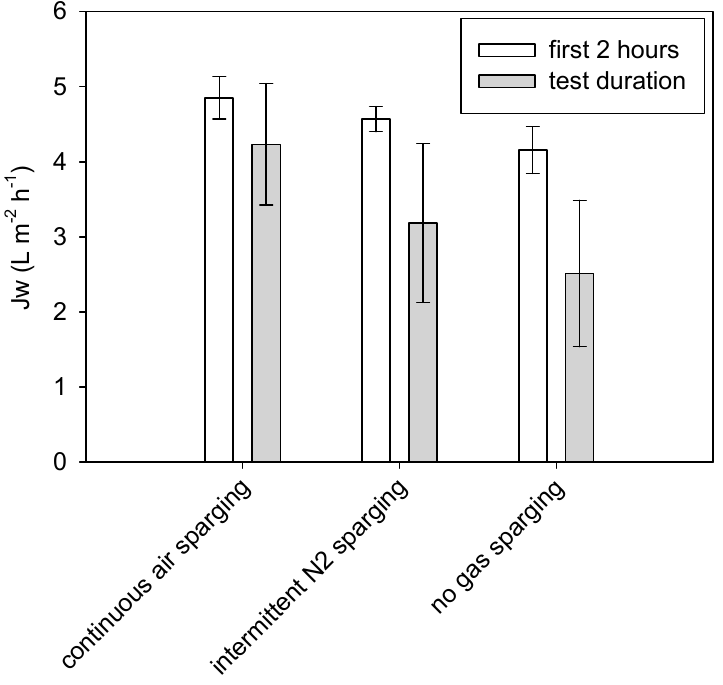
Figure 5. Average water flux with standard deviation during the first 2 h of each test and during the whole test duration, under different gas sparging conditions.